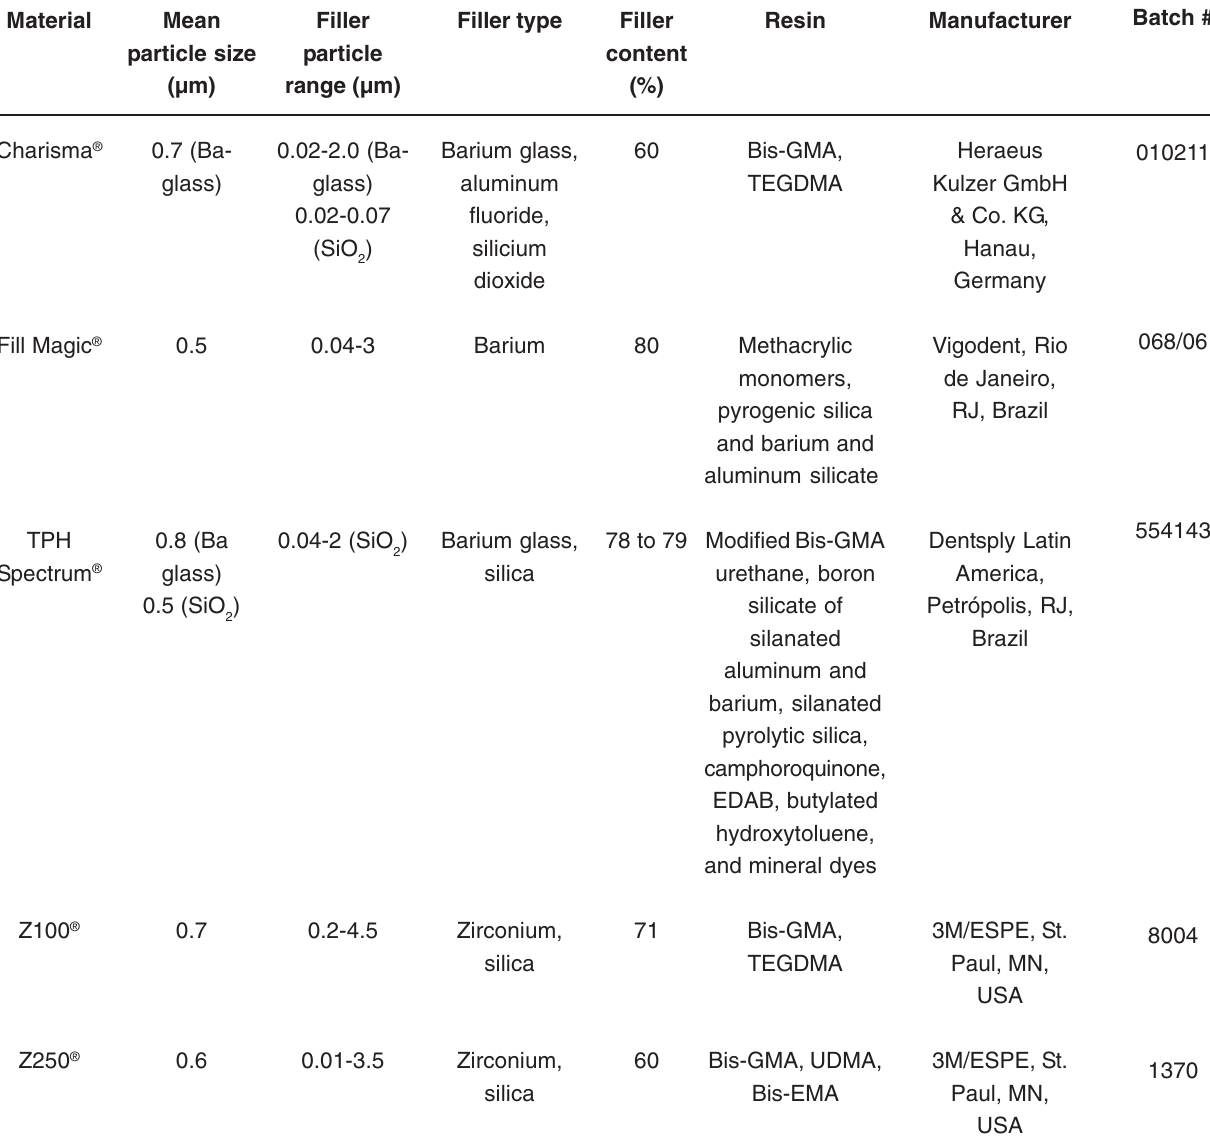
Information supplied by the